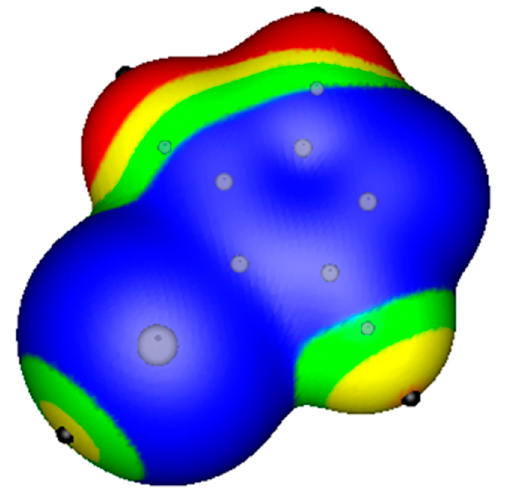
Figure 2. Computed electrostatic potential on the 0.001 au molecular surface of 4-bromo-1,2-diazole, 3 . The atom positions are as in structure 3 , the bromine being at the lower left. Color ranges, in kcal/mol: red, greater than 16; yellow, between 16 and 8; green, between 8 and 0; blue, less than 0 (negative). The black hemispheres show the locations of the most positive potentials, the V S,max , one on the bromine, and one on each hydrogen.